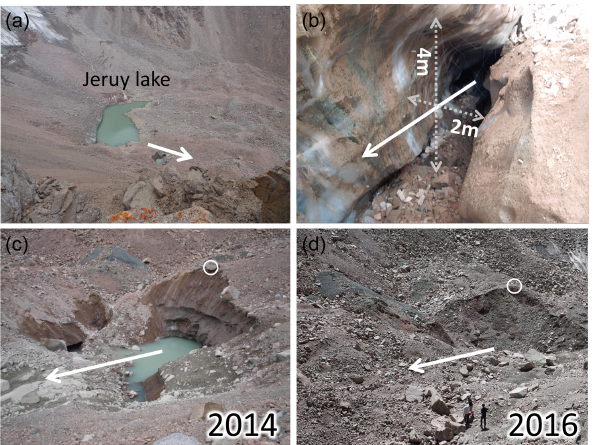
Figure 12. Basin and outlet ice tunnel of Jeruy lake, which drained on 15 August 2013. (a) Lake basin of Jeruy glacial lake on 9 August 2014. The white arrow shows the direction of lake drainage. (b) Insight into the outlet ice tunnel on 9 August 2014. (c) The outlet ice tunnel area on 9 August 2014. The white circles in panels (c) and (d) show the same location. (d) Same as panel (c) except on 9 August